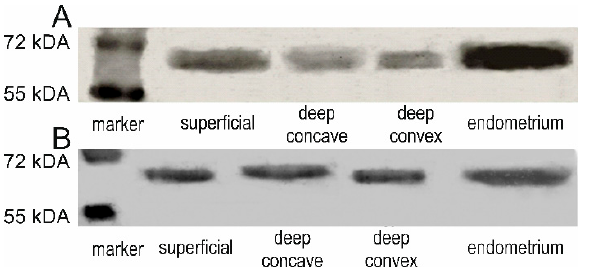
Figure 1. Representative western blot analysis showing the presence of ESR1 ( A ) and ESR2 ( B ) proteins.